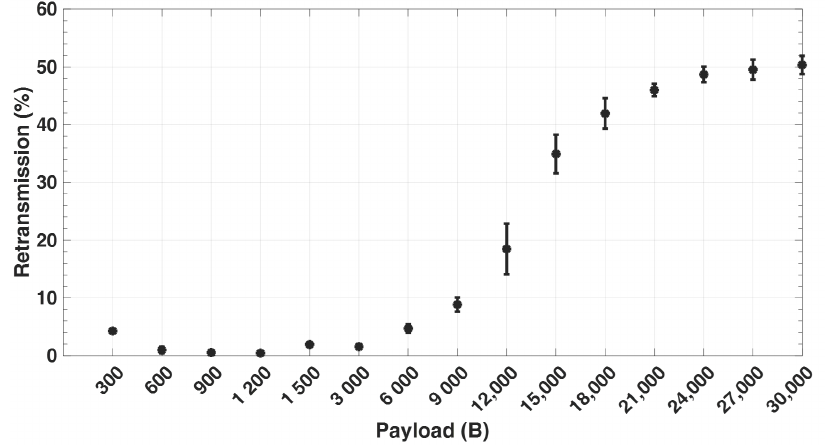
Figure 9. The packet retransmission ratio.